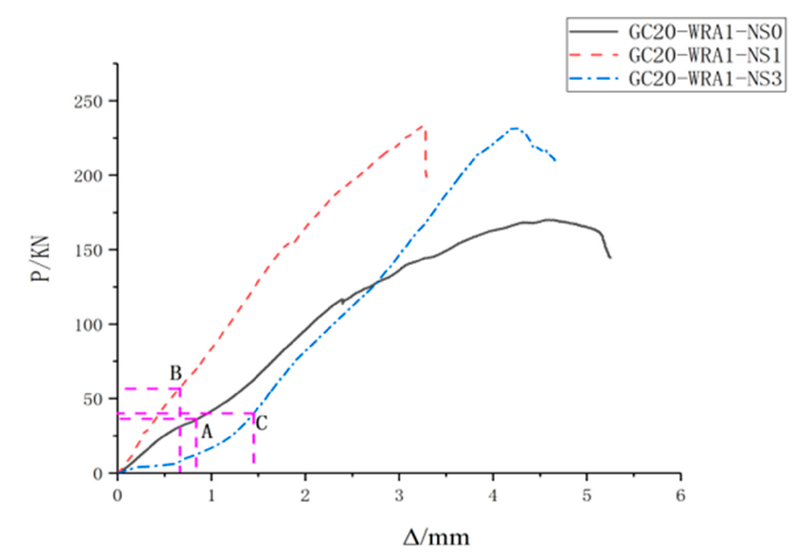
Figure 10. Load–displacement curves of specimens with different nano-SiO 2 contents.